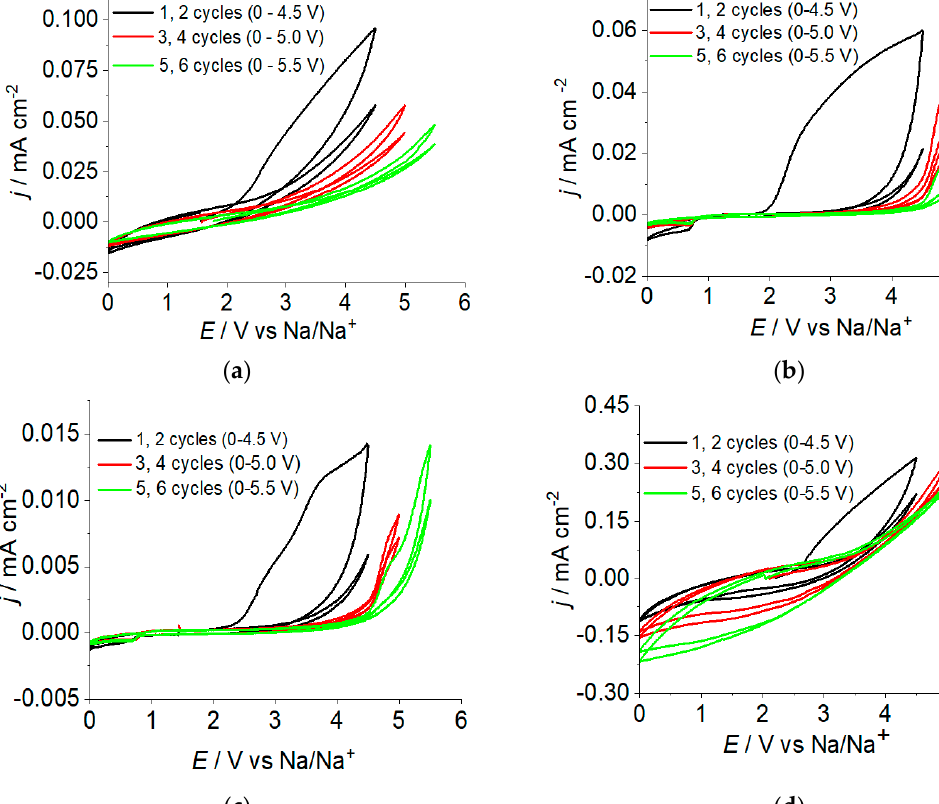
Figure 2. Aluminum electrode passivation at cyclic polarization in different electrolytes: ( a ) 1 М NaClO 4 in EC-DMA, ( b ) 1 М NaClO 4 in EC-DEC-DMA, ( c ) 1 М NaClO 4 in EC-PC-DMA-THF, and ( d ) 1 М NaClO 4 in PC-DMA-THF.